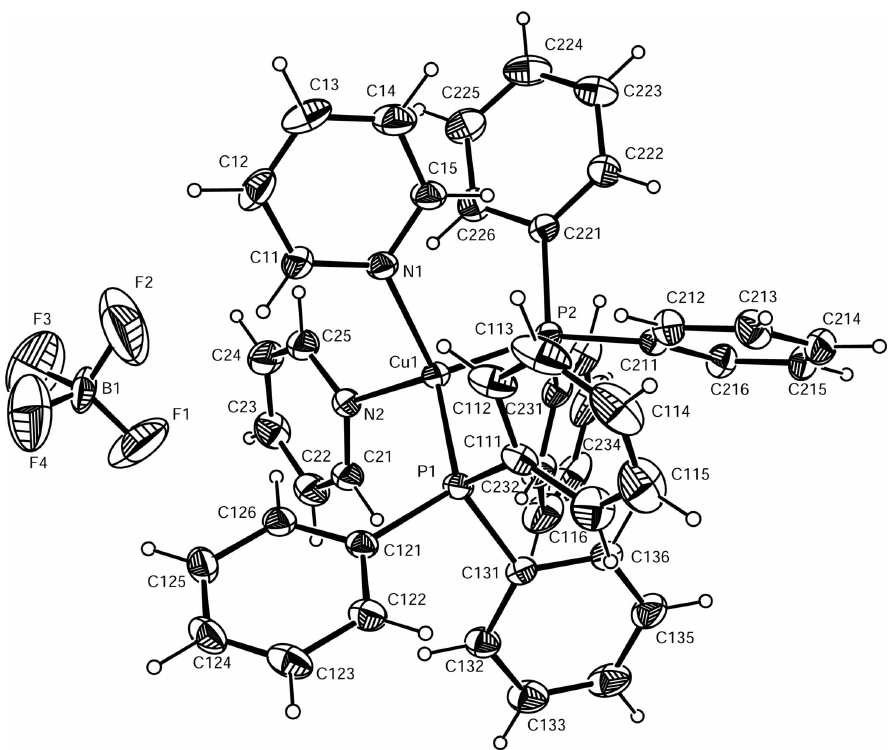
Figure 1 View of the title compound with the atom numbering scheme. Displacement ellipsoids for non-H atoms are drawn at the 30% probability level. H atoms are included with arbitrary